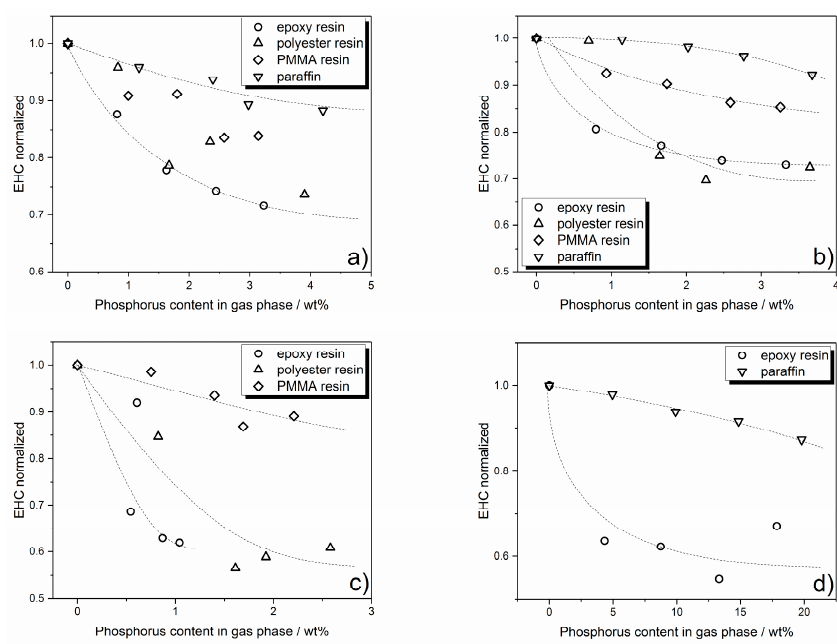
Figure 9. Effective heat of combustion versus the phosphorus content in the gas phase for the different polymeric systems flame retarded with: Exolit OP935 ( a ); Exolit OP1230 ( b ); BDP ( c ); and red phosphorus ( d ). Dotted lines are included as a guide to the eyes.